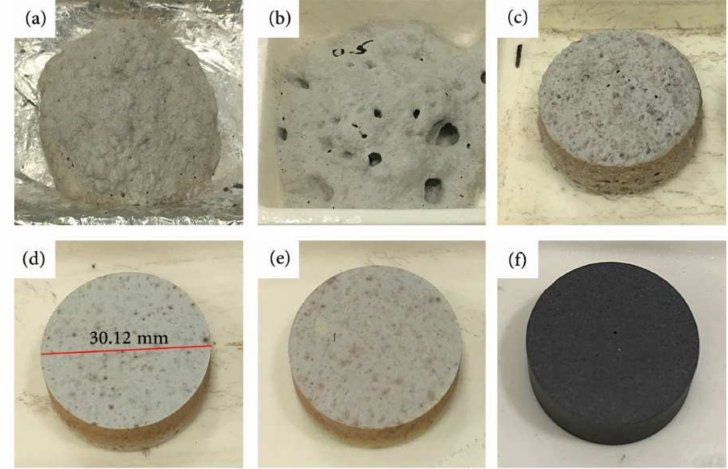
Figure 1. Photographs of the CPCMs made with different water addition: ( a ) 0%, ( b ) 5%, ( c ) 10%, ( d ) 15%, and ( e ) 20% water and ( f ) the contrast sample.